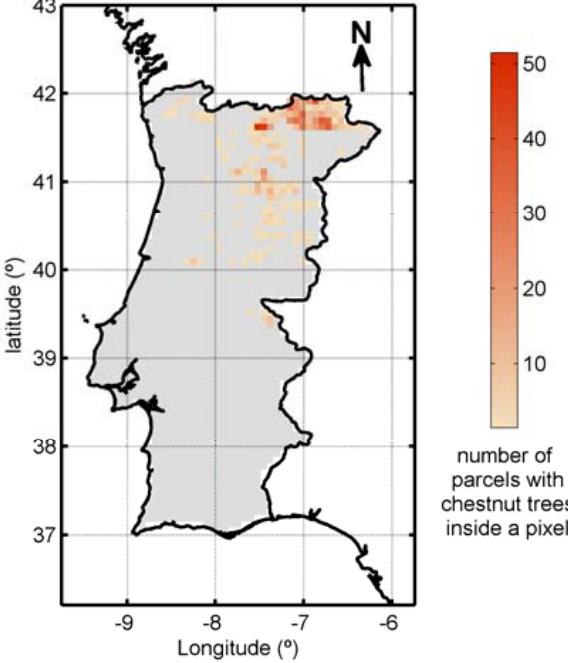
Fig. 2. Location of the pixels (8km × 8km) with chestnut trees as the main occupation with an altitude above 500m. The colour bar represents the number of land parcels with chestnut trees as the main occupation, identified by the 5th National Forestry Inventory, NFI5 (AFN, 2010), inside a GIMMS pixel (GIMMS, 2009); only the pixels with more than 10 chestnut trees were